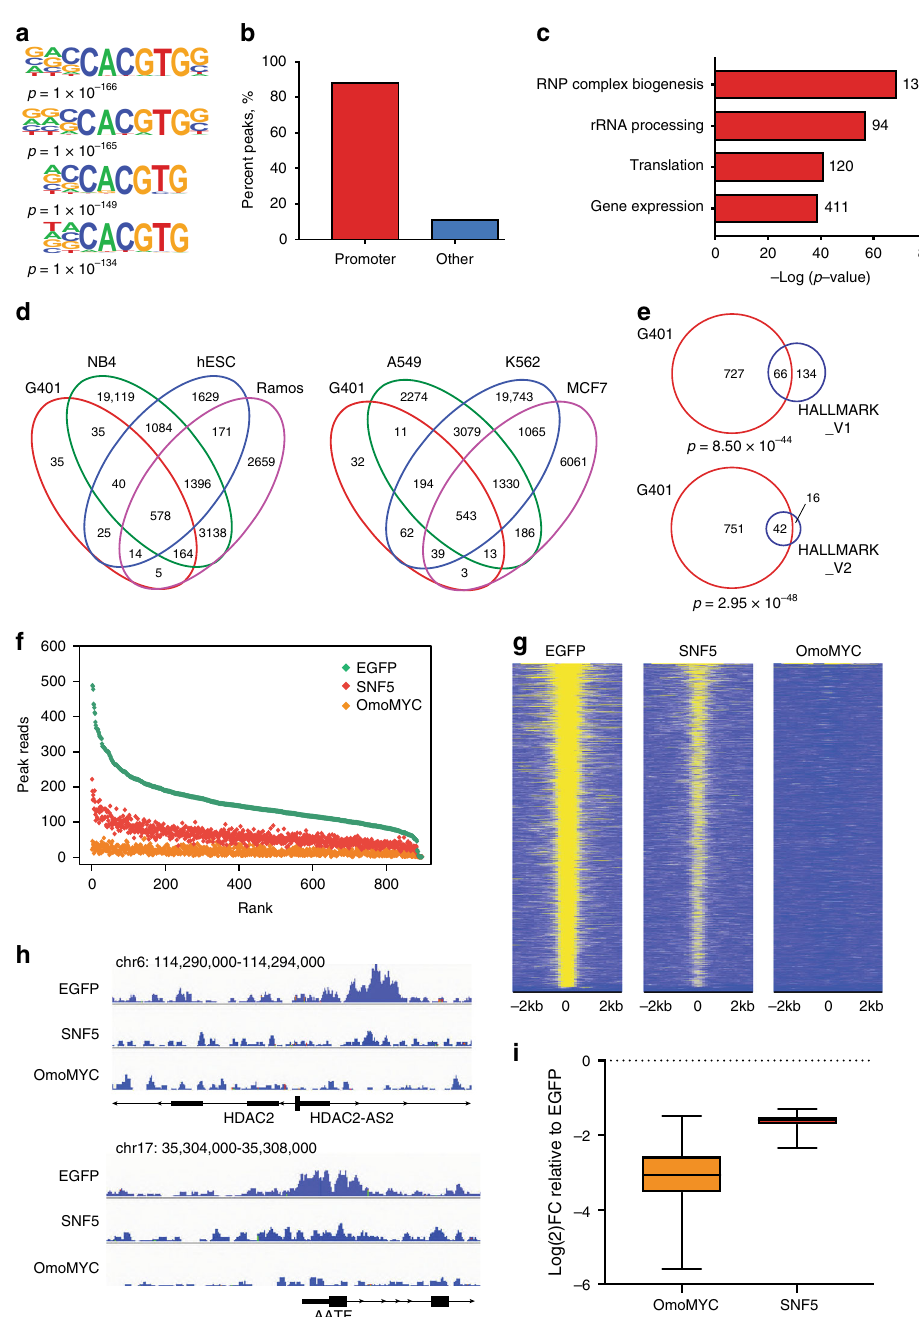
Fig. 2 SNF5 inhibits chromatin binding by MYC in MRT cells. a Known motif enrichment analysis was performed on the ChIP-Seq data from G401 cells expressing EGFP. The top four motifs are shown; all are enriched in the E-box sequence (CACGTG). b MYC peaks in the EGFP-expressing cells were quanti fi ed in terms of their distance to the nearest annotated transcriptional start-site (TSS). Peaks within 1 kb of a TSS are called as “ promoter ” peaks. c MYC peaks located within 1 kb from a TSS were assigned to their nearest gene and GO term enrichment analysis was performed. d Overlap of MYC peaks obtained from EGFP-expressing G401 cells with six published MYC ChIP-seq data sets: NB4 acute promyelocytic leukemia cells (GSM935643), hESC human embryonic stem cells (GSM935509), Ramos Burkitt ’ s lymphoma cells (GSM762711), A549 lung cancer cells (GSM1003607), K562 chronic myeloid leukemia cells (GSM935516), and MCF7 breast cancer cells (GSM1006866). e MYC peaks that are located within 1 kb from a TSS were assigned to their nearest gene and overlaid with two MSigDB Hallmark MYC target data sets. A hypergeometric test was performed; signi fi cance is displayed below the Venn diagram. f Scatterplot of normalized peak read counts for each condition (average of replicates), ranked based on EGFP peak read number. g Heat maps of MYC peak intensity for each condition representing the combined average of normalized peak intensity in 100-bp bins ± 2 kb around the center of peaks. Genes ranked based on EGFP. h Two example genome browser tracks from each condition. i Box-and-whisker plot of log 2 -fold changes of MYC peaks for OMOMYC or SNF5 samples (FDR < 0.05), relative to EGFP. Box extends from 25th to 75th percentile with median marked by the middle line, whiskers extend from minimum to maximum point. n = 2 independent ChIP-seq